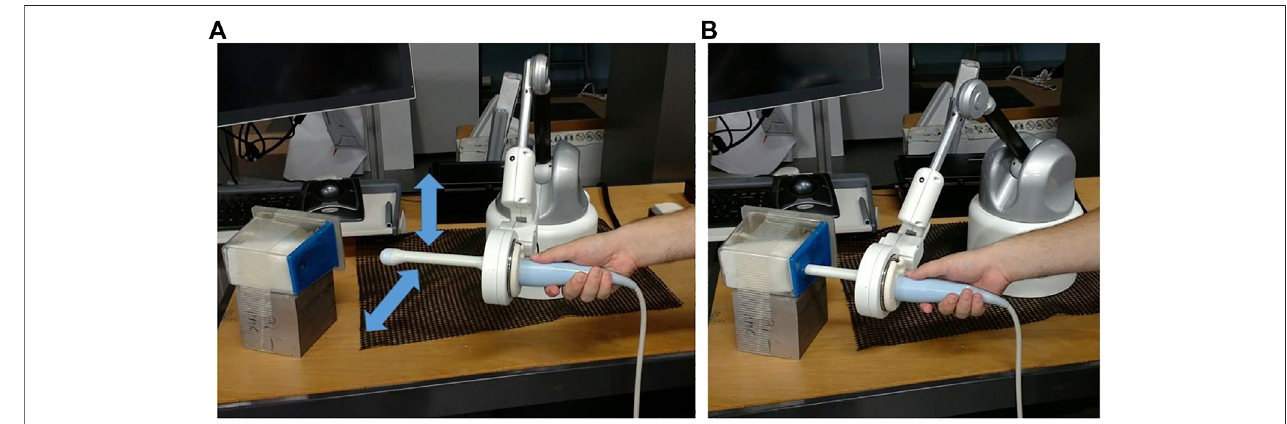
FIGURE 6 | Experimental setup without environmental constraints (A) , in an anatomical phantom (B)